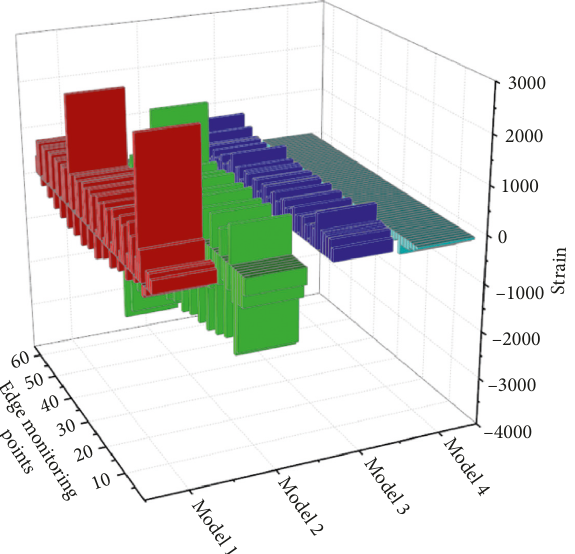
Figure 19: Strain histogram of U-shaped steel under blasting disturbance. Model 1 to Model 4 refer to the strain of U-shaped steels with explosion amounts of 32kg, 40kg, 48kg, and 60kg, respectively.